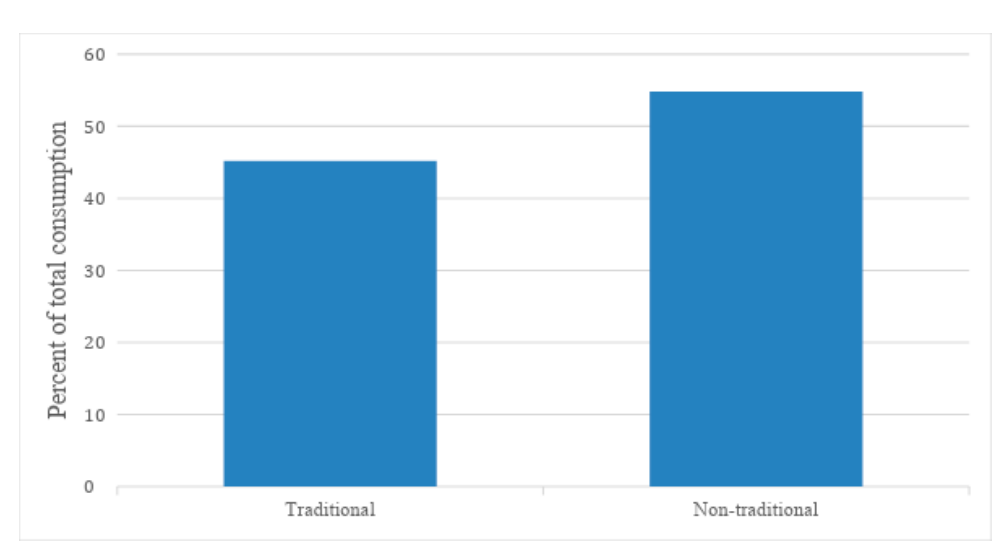
Figure 6. Overall proportion of traditional and non-traditional mixed meal consumption per 10 h day.